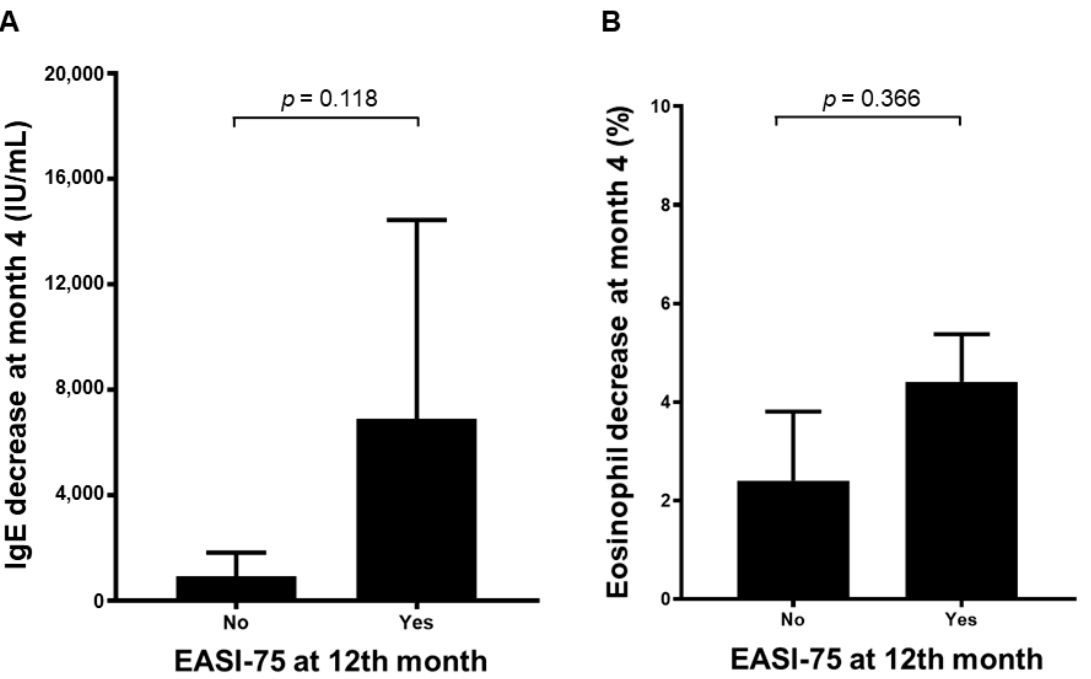
Figure 2. Trends in IgE and eosinophil count. A trend toward a higher decrease in total IgE ( A ) and eosinophil ( B ) at 4th month in patients who had an EASI-75 at the 12th month compared with that in patients who did not have an EASI-75 at the 12th month but without significant difference.